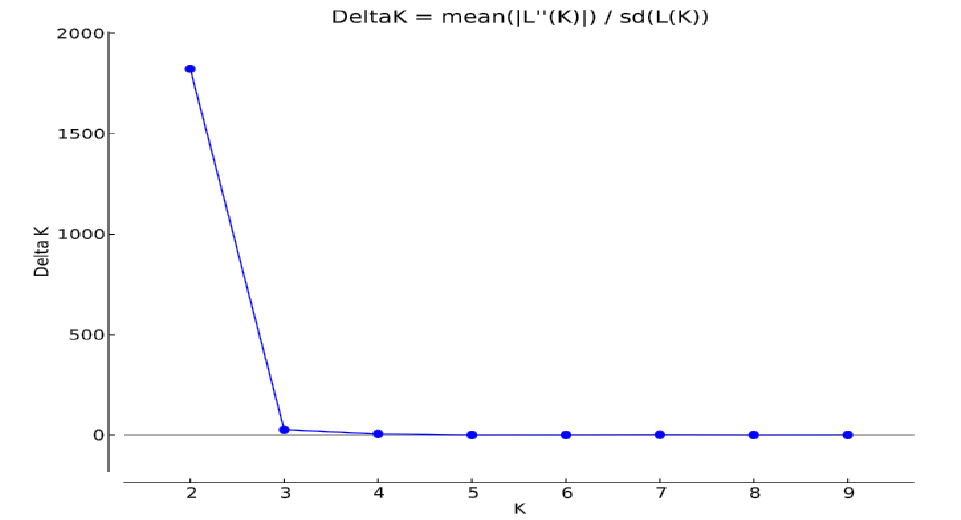
Figure 4. Log probability of the data (LnP(D)) for structure estimation of the number of subgroups from K -values ranging from 1 to 10 by ΔK values (gray line = initial modal value).